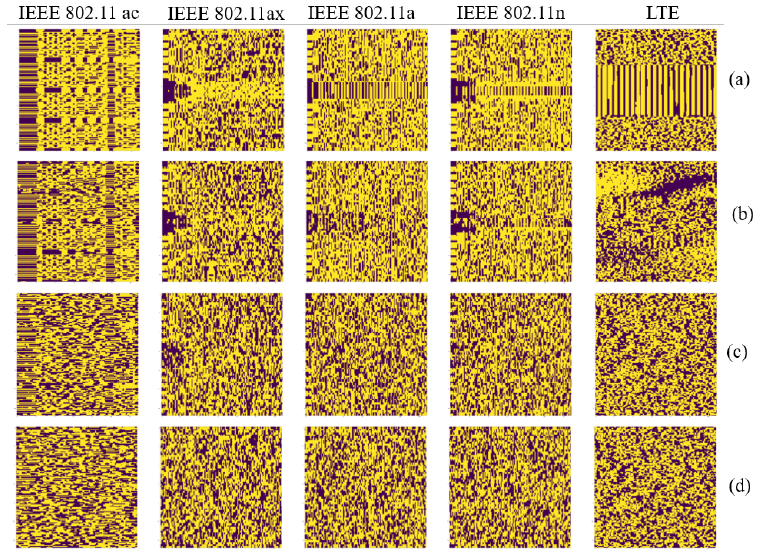
Figure 2. Spectrograms for different IEEE 802.11 protocols and unlicensed LTE signals: ( a ) the transmitted spectrograms, the received spectrograms for ( b ) Scenario 2 and SNR 20 dB, ( c ) Scenario 1 and SNR 5 dB, and ( d ) Scenario 1 and SNR 0 dB.